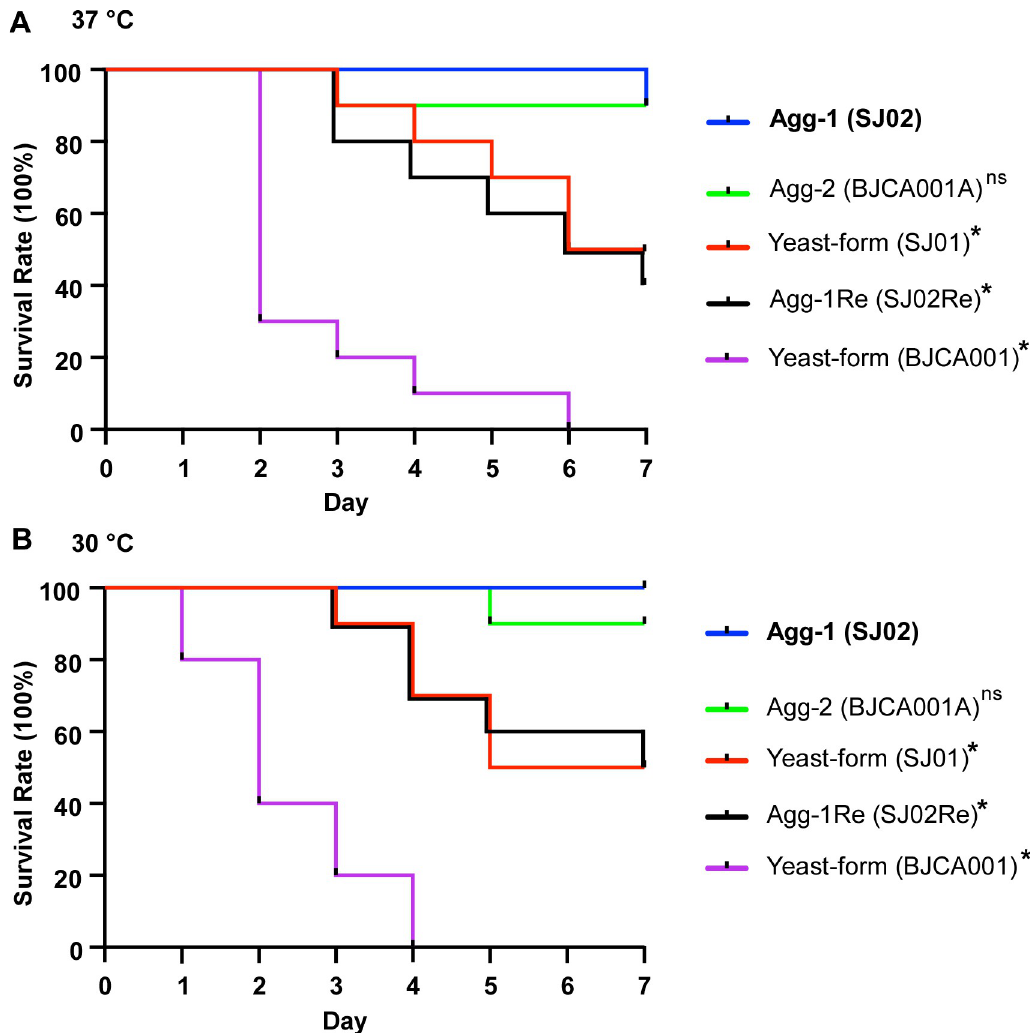
Fig 2. Survival curves of G . mellonella larvae infected with C . auris nonaggregative/yeast-form (SJ01 and BJCA001) and aggregative-form (SJ02 and BJCA001A) strains. Approximately 1 x 10 6 C . auris cells of each strain were injected into each G . mellonella larva. Ten larvae were injected for each strain. ns, no significant difference; � , significant difference (p < 0.05, by log rank test. Strain SJ02 served as the control). (A) Survival curves from experiments performed at 37˚C. (B) Survival curves from experiments performed at